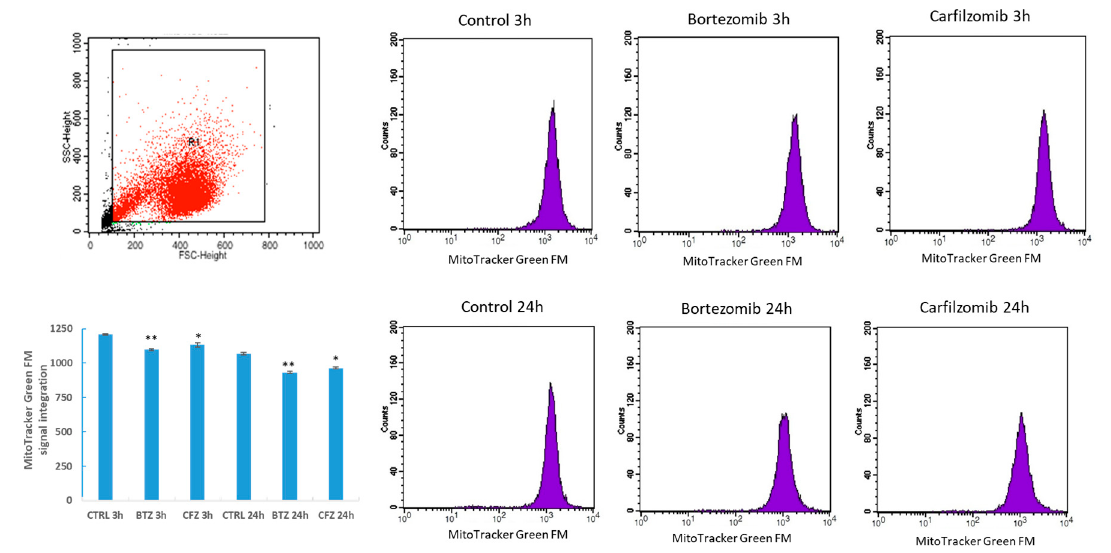
Figure 4. Flow cytometry analysis of MitoTracker Green FM mitochondrial staining in neuronal cells after BTZ and CFZ treatments. Values represent means ± SD, n = 3. * p < 0.05, ** p < 0.01 (CNTRL: